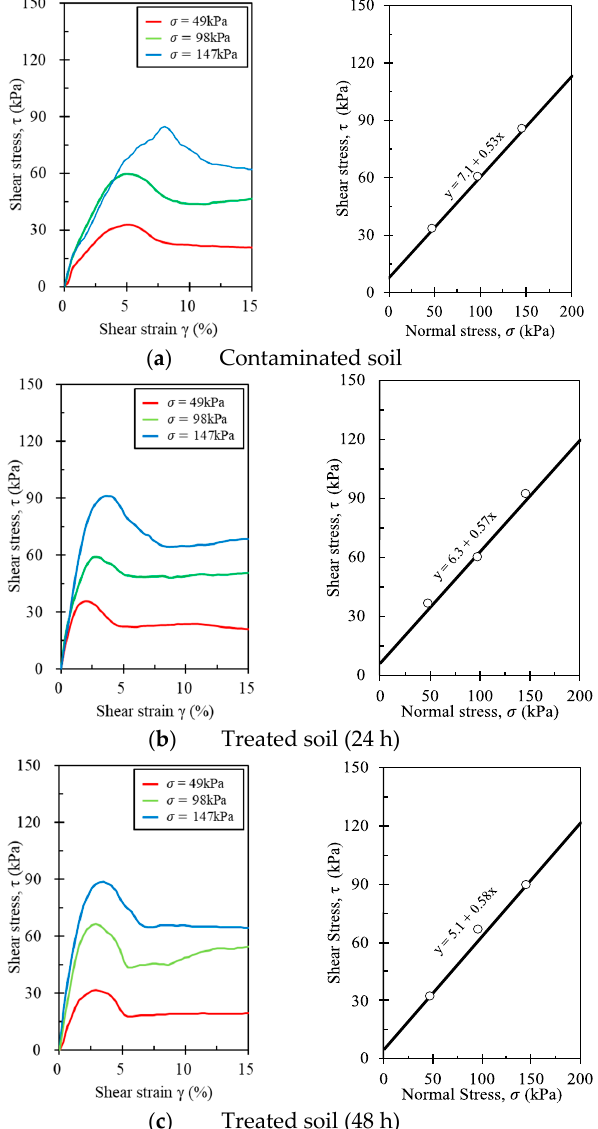
Figure 9. Shear strain–shear stress responses and Mohr–Coulomb failure envelope: ( a ) Contaminated soil; ( b ) treated soil (24 h); ( c ) treated soil (48